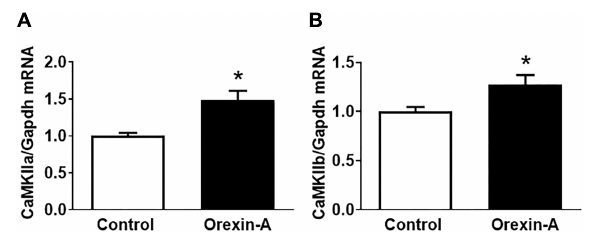
FIGURE 1 | ICV injection of orexin-A increases mRNA expression of CaMKIIa and CamKIIb in the PVN of SD rats. Adult male SD rats received ICV injection of either orexin-A or vehicle control. The rats were euthanized 3 h following microinjection, and PVN tissue was harvested and subjected to real-time PCR to measure mRNA expression of CaMKIIa (A) and CaMKIIb (B) . The data were normalized to GAPDH mRNA and the average mRNA levels in control rats were assigned an arbitrary unit of 1 ( n = 5/group). P = 0.006 for the CaMKIIa mRNA (A) increase and P = 0.022 for the CaMKIIb mRNA (B) increase. * P <